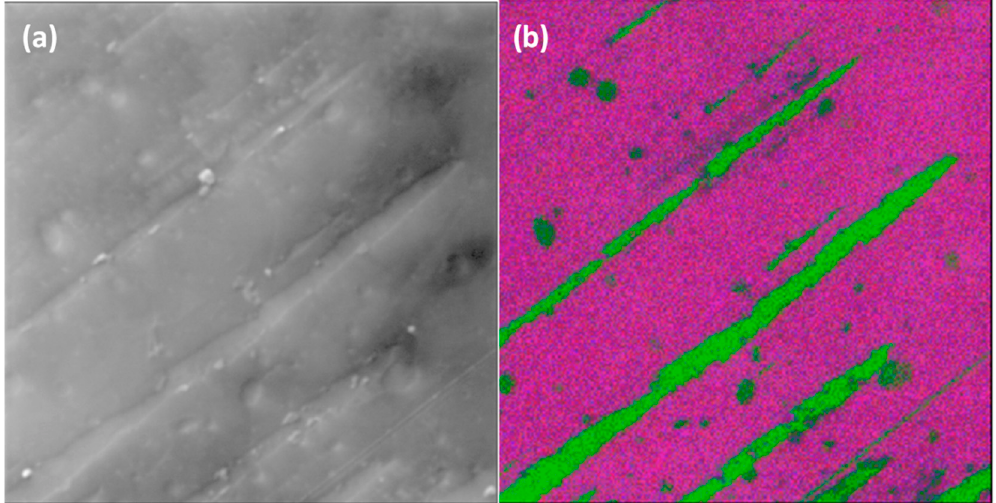
207 Figure 3. SEM image from propyltrimethoxysilane (PTMS) 3 (left) and (right) RGB overlay of carbon 208 (green), oxygen (blue), and silicon (red) elemental maps (FOV 200 μ m). 209